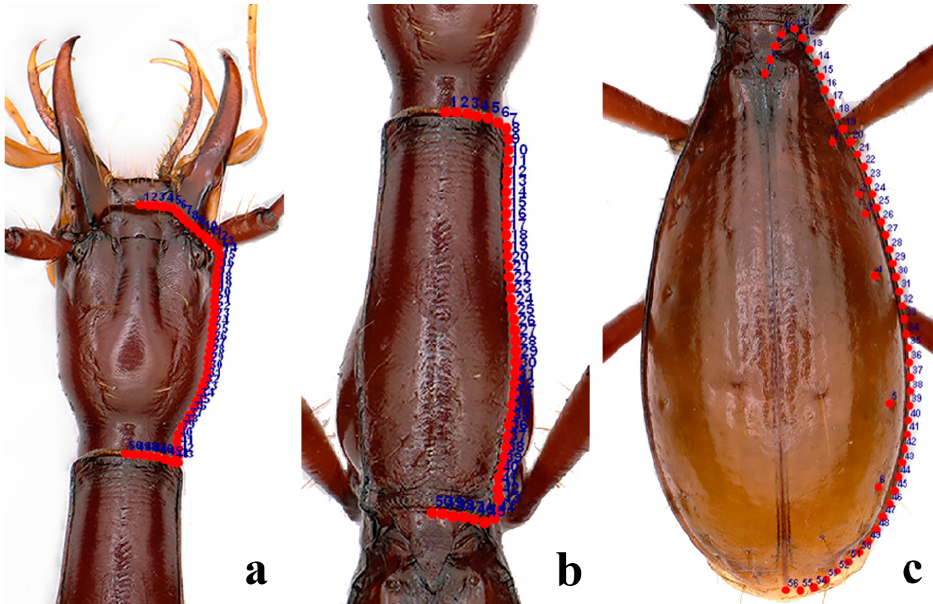
Figure 2. Landmark and semilandmark configurations of ground beetle specimens. ( a ) The right side of the head (50 positions); ( b ) right side of the pronotum (50 positions); and ( c ) right side of the elytra (56 positions).